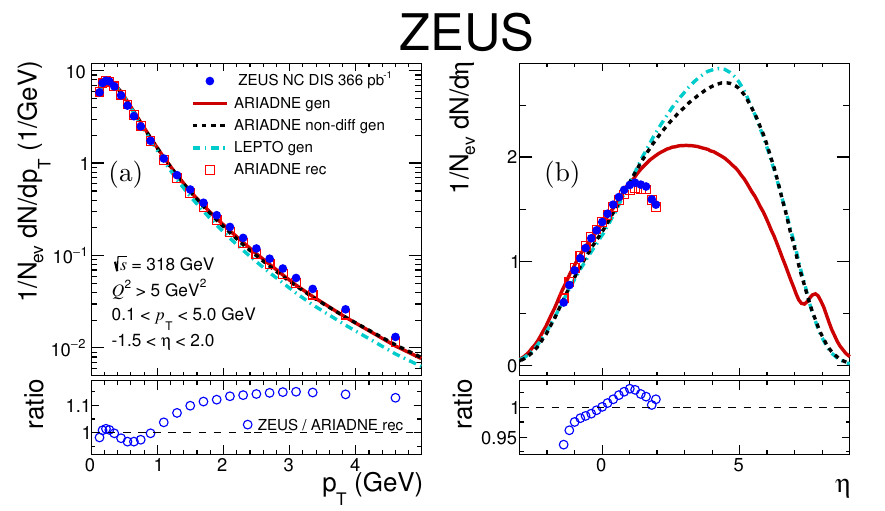
Figure 2 . Reconstructed distributions of (a) p T and (b) (cid:17) in data compared to LEPTO and ARIADNE. The reconstructed distributions are (cid:12)rst normalised by their respective total number of events, N ev . The generator-level predictions of ARIADNE are normalised to reconstructed ARIADNE at (a) p T = 0 : 1 GeV and at (b) (cid:17) = 0. The other model predictions have been normalised by the same factor (1.3). The kink in the ARIADNE prediction near (cid:17) = 8 arises from the contribution of di(cid:11)ractive events where the incoming proton remains intact. The other details are as in (cid:12)gure